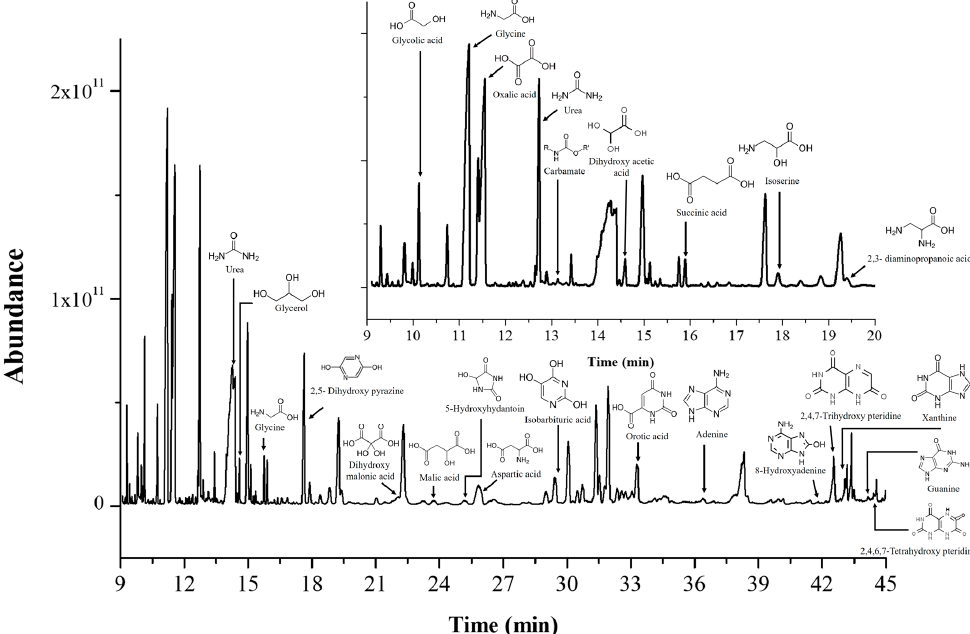
Figure 4. GC-MS chromatogram of hydrolyzed HCN-DTP samples. The profile shows some organic molecules released after acid hydrolysis. molecules released after acid